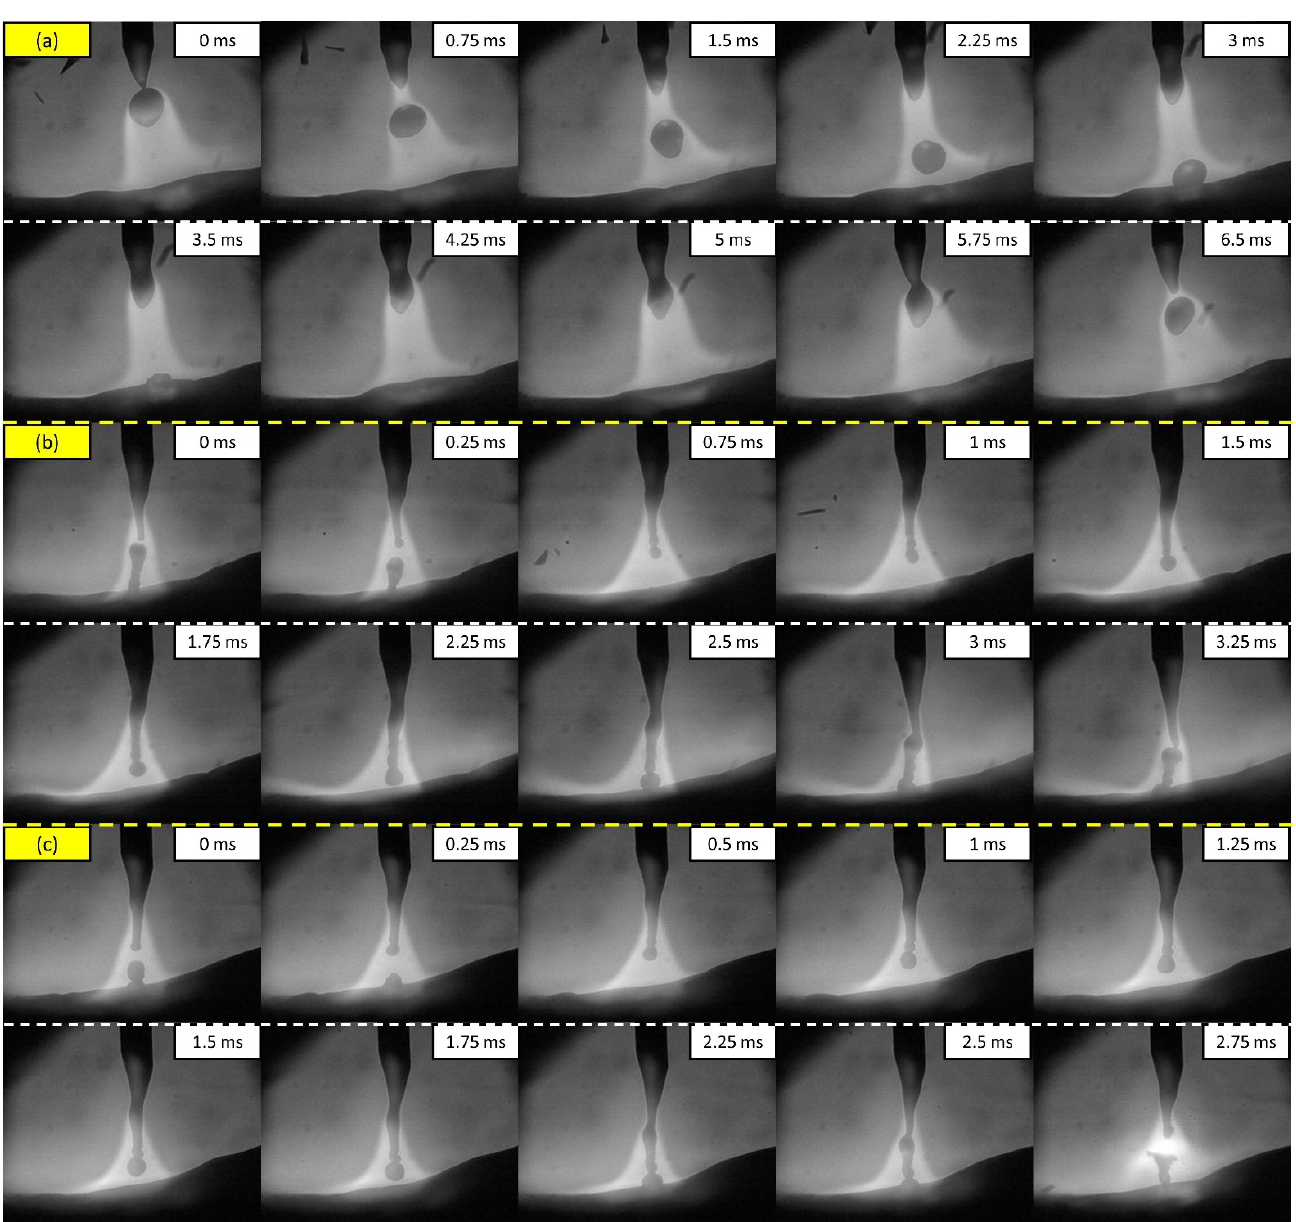
Figure 2. Sequential images of metal transfer in solid wire in 220 A ( a ), 250 A ( b ), and 280 A ( c ) of welding current.